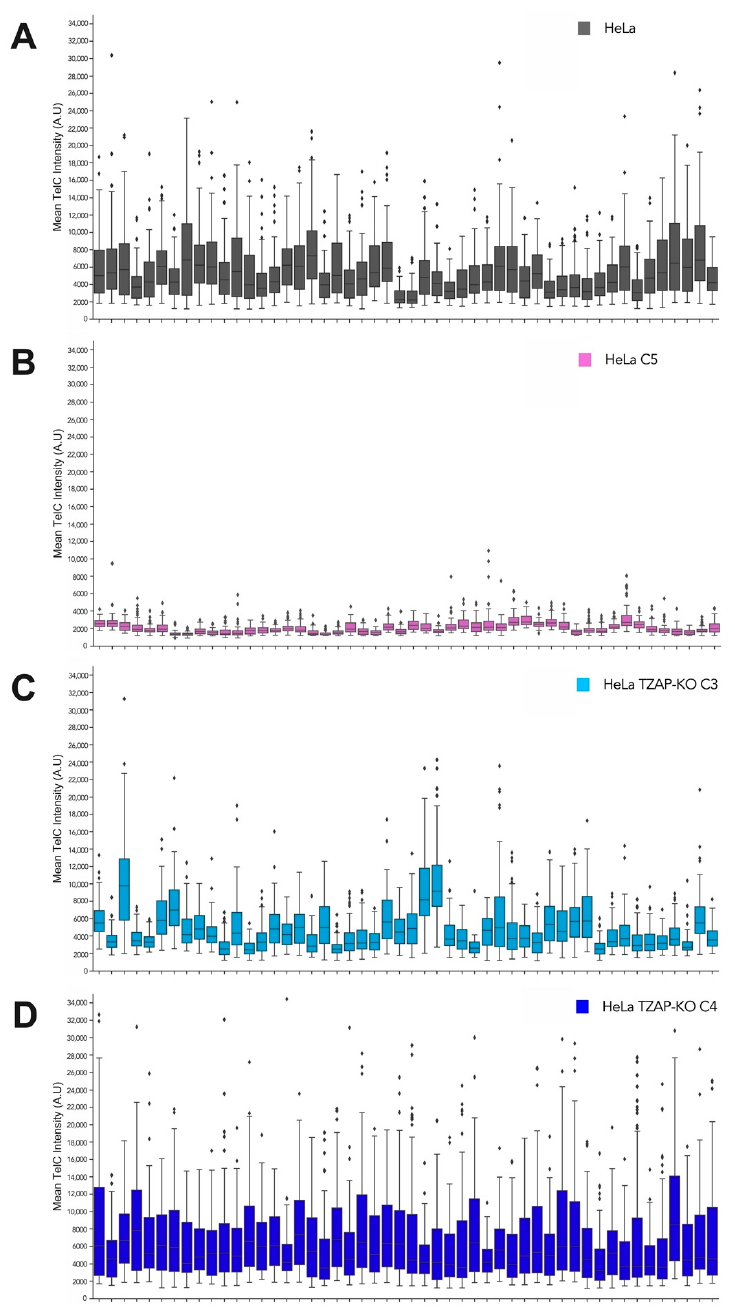
Figure 2. Uniformity of HeLa telomere length phenotype at individual cell level. Box plots of the mean telomere fluorescence intensity for fifty cells for ( A ) HeLa Kyoto parental, ( B ) HeLa C5, ( C ) HeLa TZAP-KO C3 and ( D ) HeLa TZAP-KO C4. Prisms are outliers defined as points > 75th quartile + 1.5* interquartile range.